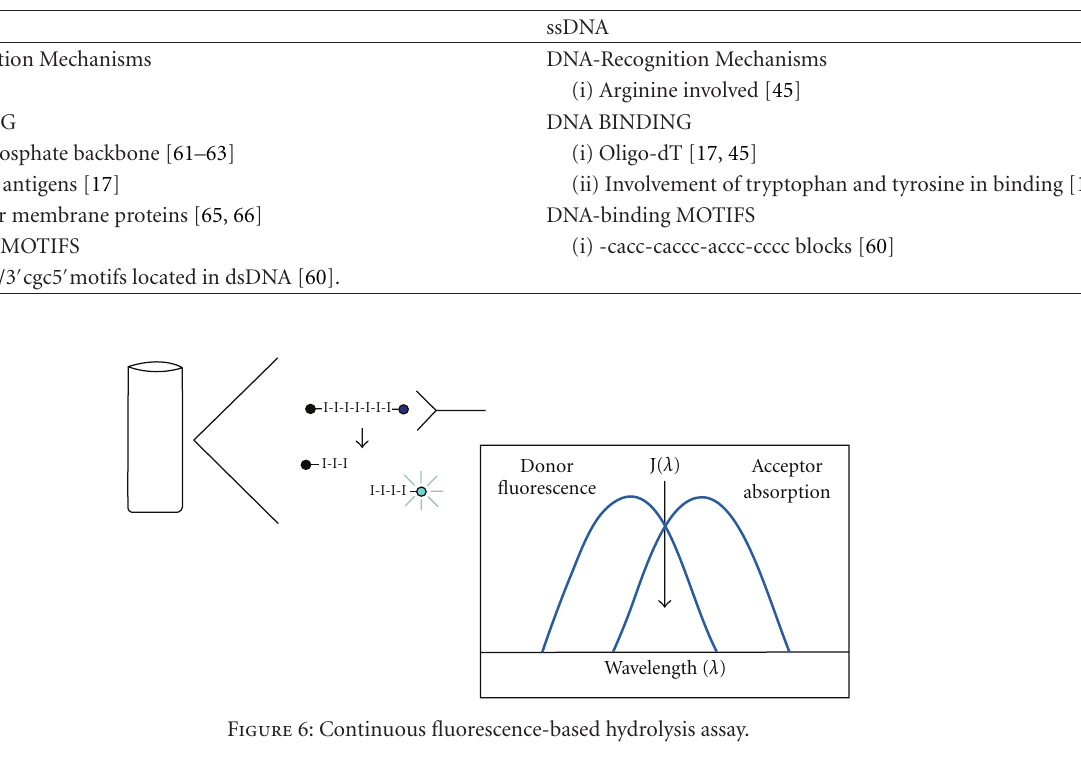
Table 2: DNA recognition and binding by anti-DNA autoantibodies.